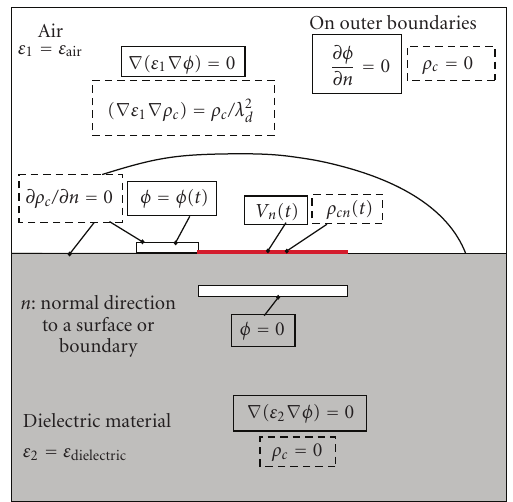
Figure 2: Equations and boundary conditions for the hybrid model: equation (1) (solid boxes) and equation (2) (dashed boxes)